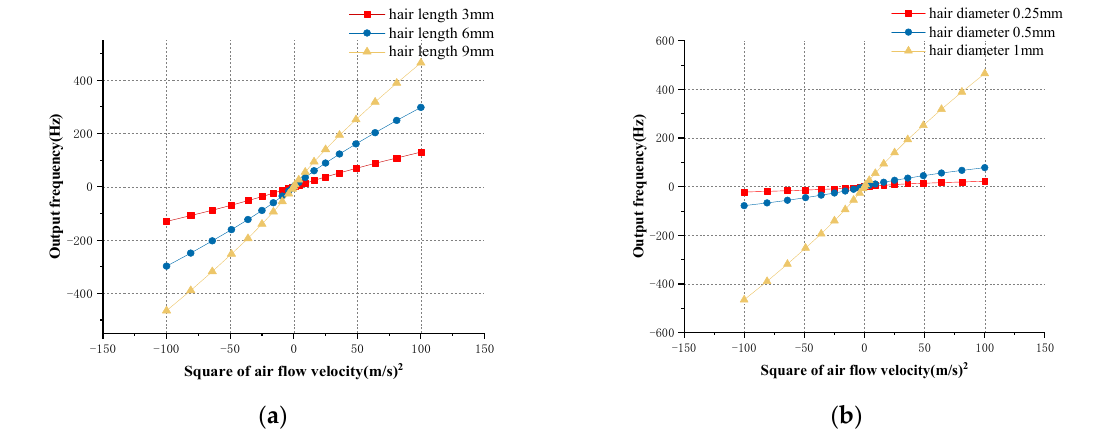
Figure 6. The influence simulation of hair parameters on input and output characteristics. ( a ) The output frequencies versus square of input air flow velocity in different hair lengths of 3 mm, 6 mm, and 9 mm (the hair diameter is 1mm); ( b ) The output frequencies versus square of input air flow velocity in different hair diameter of 0.25 mm, 0.5 mm, and 1 mm (the hair length is 9 mm).